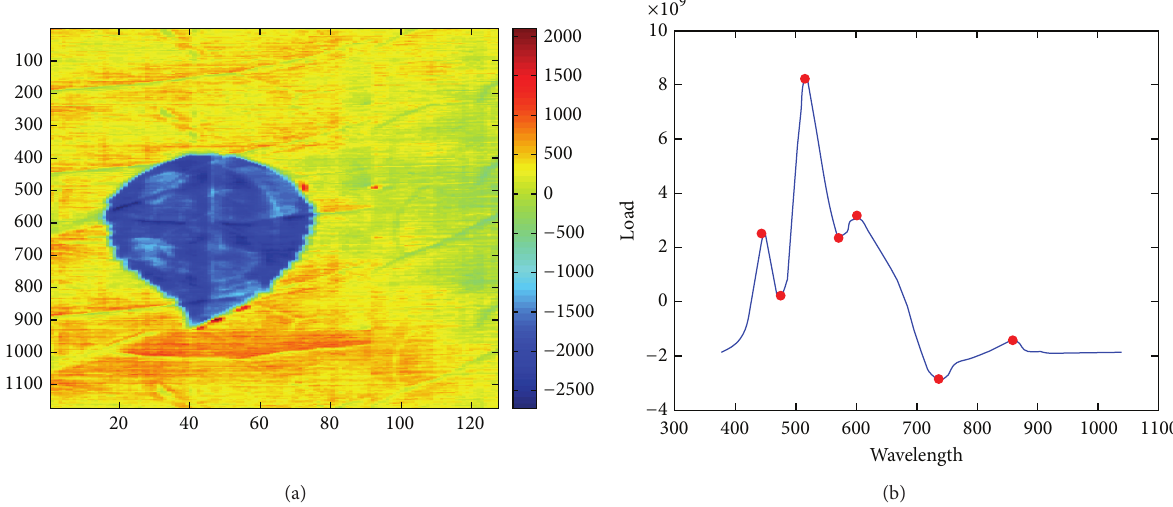
Figure 6: Baseline method of band selection by PCA [6]: (a) principal component: PC2 and (b) load function curve of PC2.